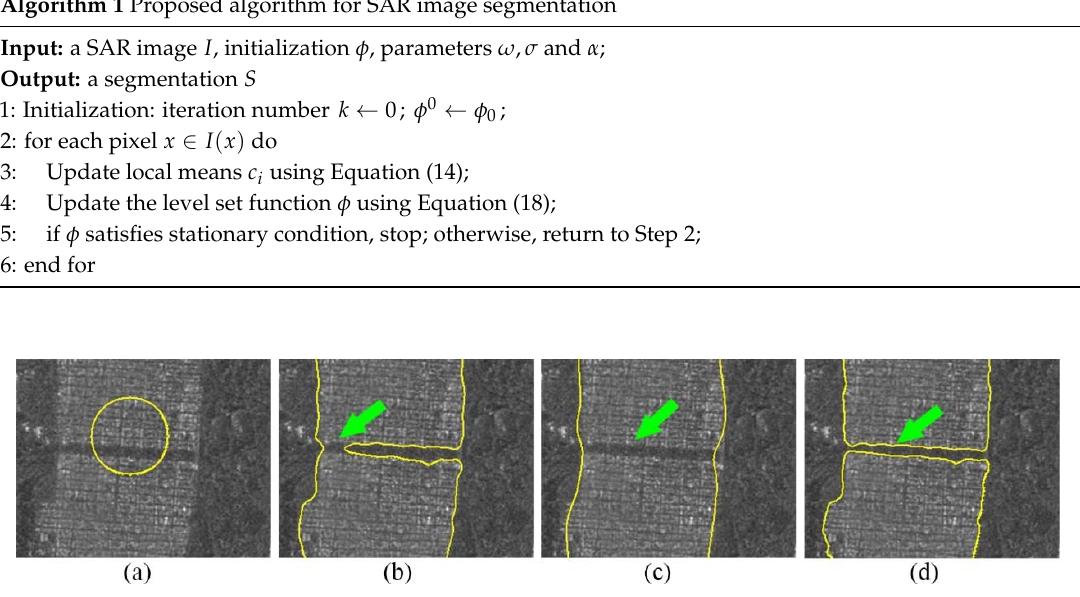
Figure 3. Segmentation result on an airborne SAR image. ( a ) Original image and initial contour. ( b ) Segmentation result of Equation (17). ( c ) Segmentation result of Equation (17) + reinitialization method. ( d ) Segmentation result of Equation (18).